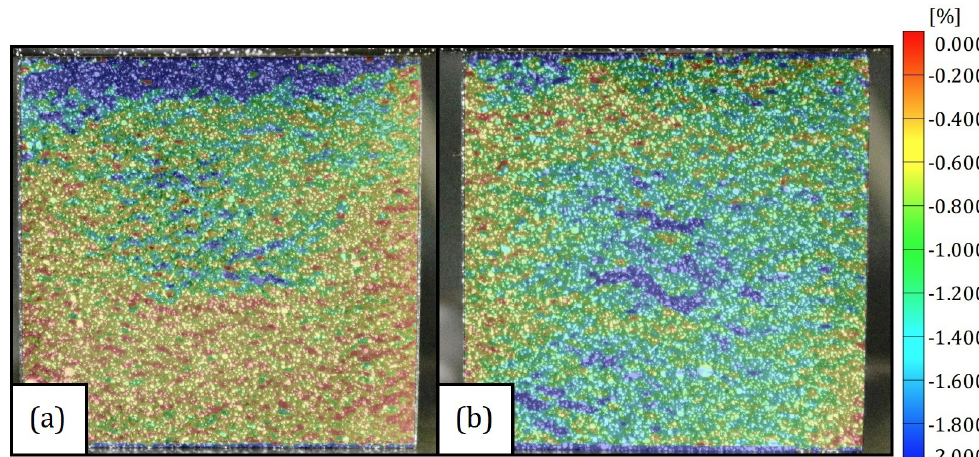
Figure 11. DIC strain field for ( a ) Dir3 and ( b )